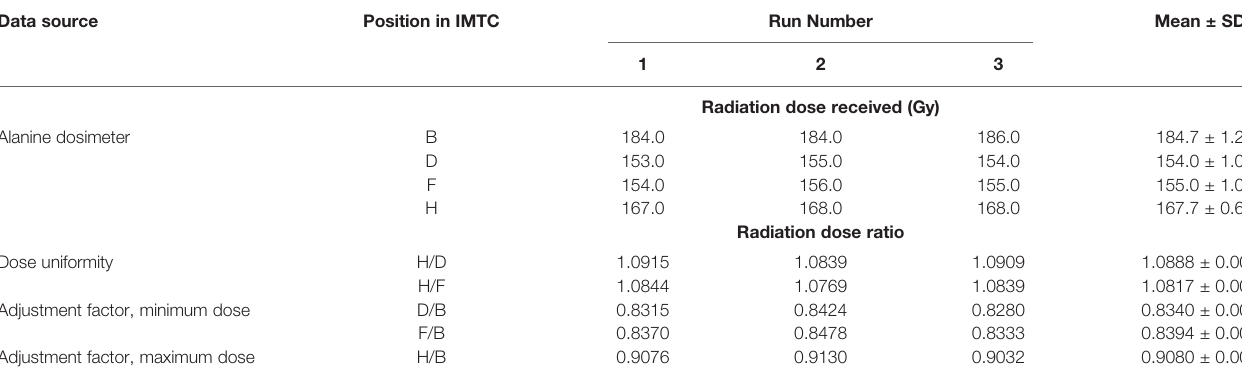
TABLE 2 | Mapping of the new